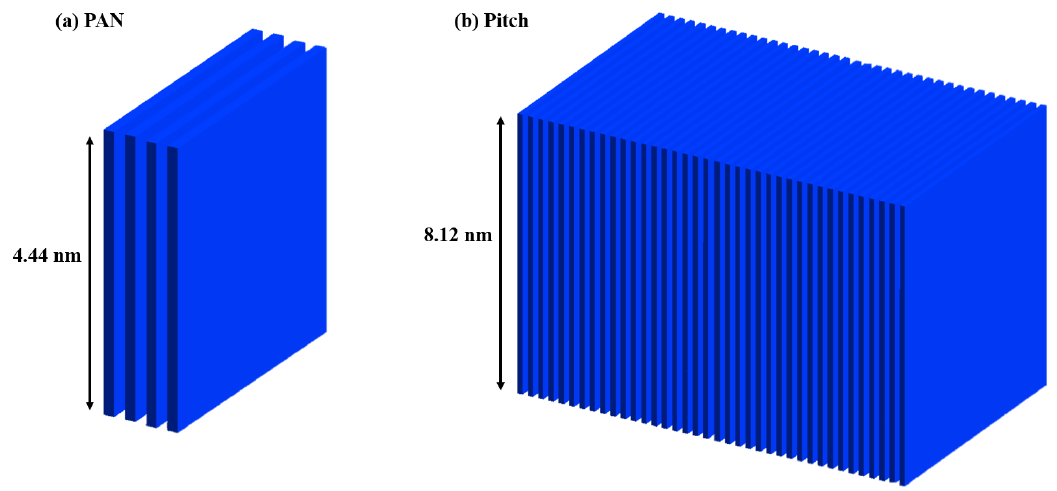
Figure 7. Digitization of crystalline structure information used as RVEs. ( a ) For PAN-based carbon fiber; ( b ) For pitch-based carbon fiber.